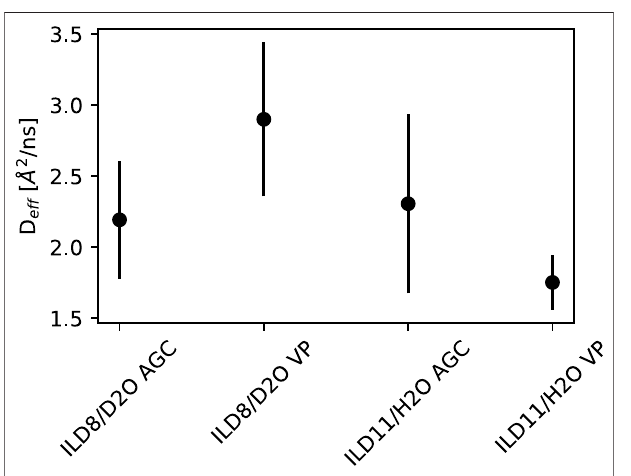
FIGURE 6 | Diffusion coef fi cients measured at 265 K for the four samples.